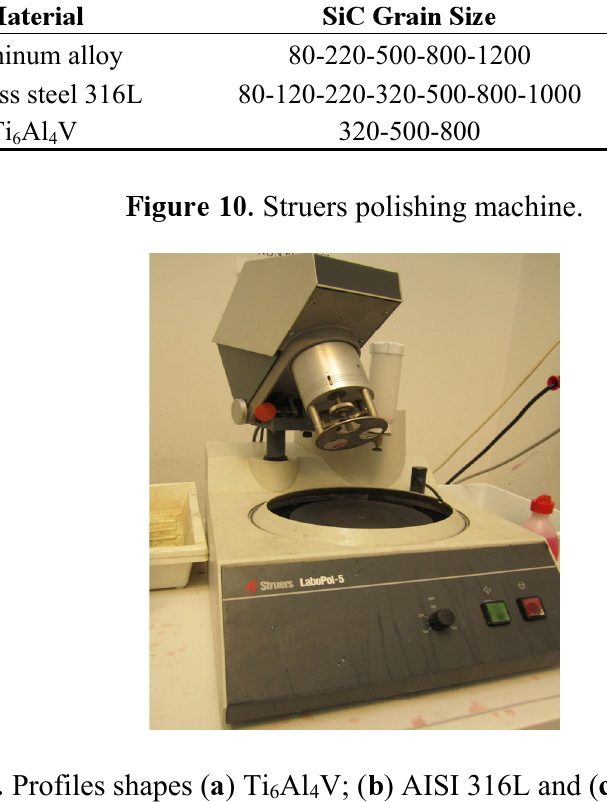
Figure 11. Profiles shapes ( a ) Ti